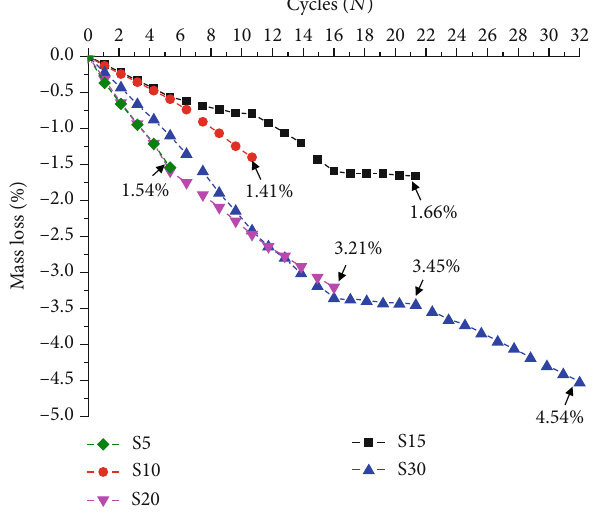
Figure 5: Sandstone specimen mass loss rate.